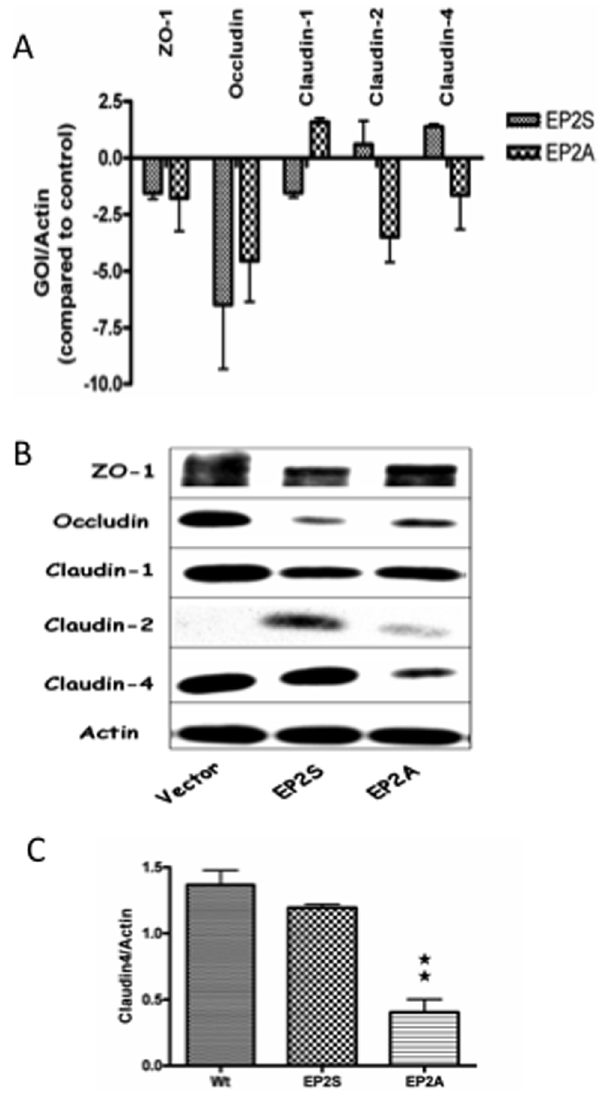
Figure 3. The expression of tight junction mRNA and proteins in Caco-2 EP2 receptor transfectants. (A) The mRNA expression for tight junction proteins (ZO-1, occludin, claudin-1, claudin-2 and claudin- 4) in Caco-2 EP2S and EP2A cells was measured by Q-PCR. The expression of gene of interest (GOI) was normalized with the internal control (Actin) and expressed as fold changes with that of the vector control. (B) A representative immunoblot showing constitutive expres- sion of the important tight junction proteins (ZO-1, occludin, claudin-1, claudin-2 and claudin-4) in EP2S, EP2A and vector control cells. Actin used as internal control. (C) Densitometry analysis for claudin-4 expression in EP2S, EP2A and vector control cells. EP2A compared statistically with the vector control. ww p ,